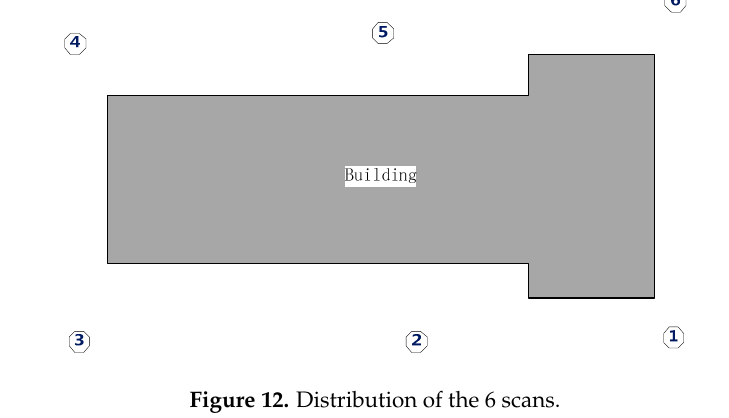
Figure 12. Distribution of the 6 scans. Table 4. Basic information of each scan.